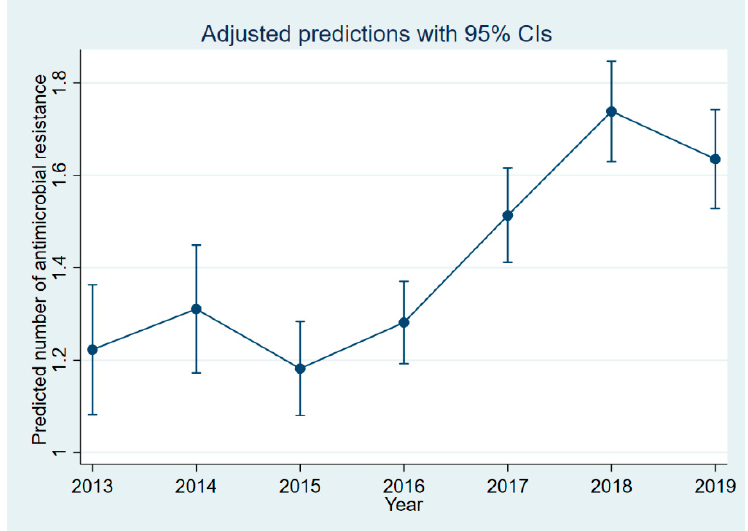
Figure 5. Poisson regression model result of the predicted number of antimicrobials to which an E. coli isolate was resistant each